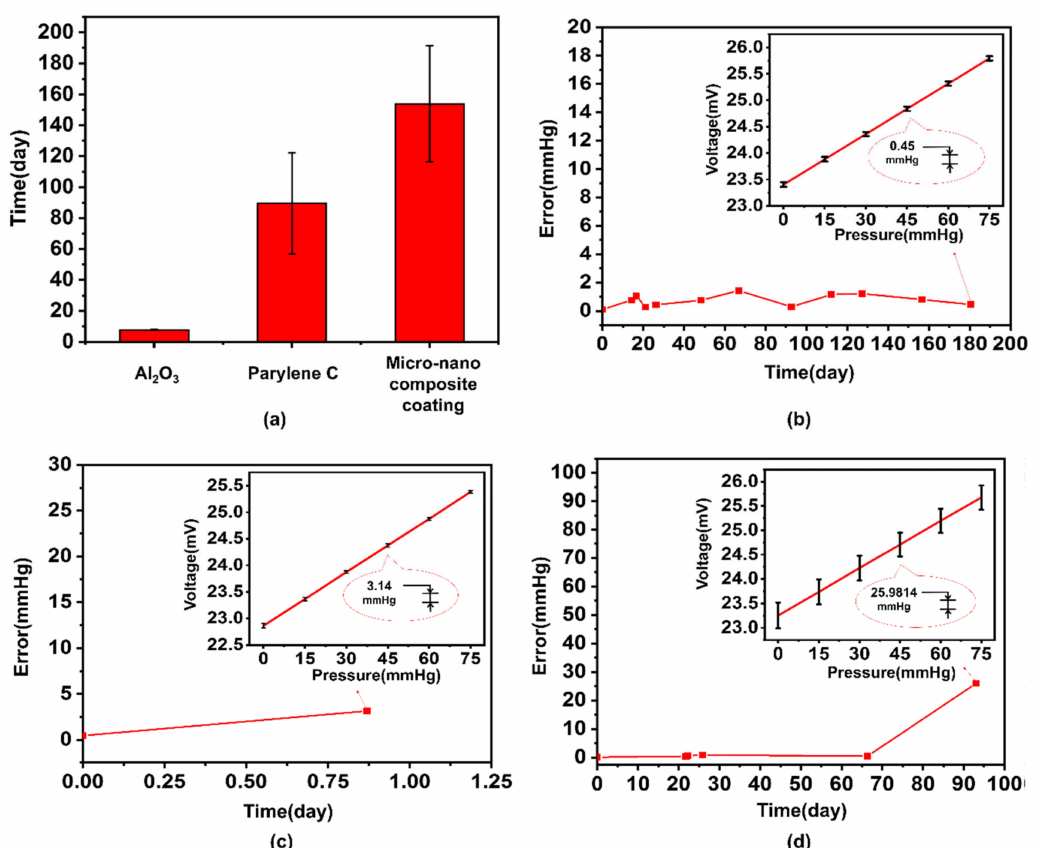
Figure 3. ( a ) Working life of sensors with three encapsulation methods in simulated body fluids; ( b ) relationship between sensor error and waterproof time of the defect filling method of micro-nano composite coating; ( c ) relationship between the error of the sensor coated only with Al 2 O 3 and the waterproof time; ( d ) relationship between parylene-only sensor error and waterproof